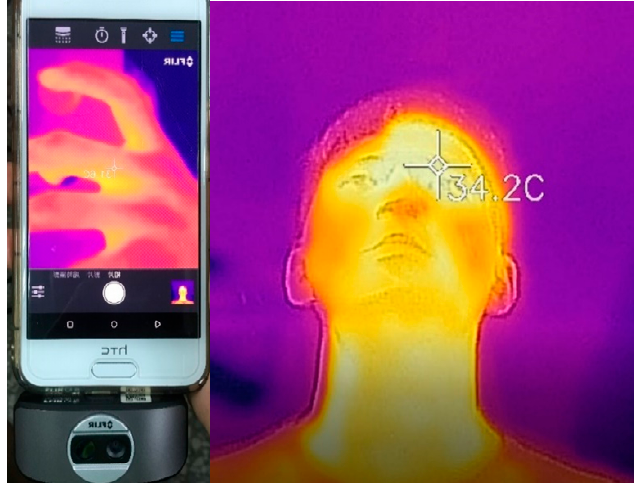
Figure 7. Thermal camera and measured dynamic body temperature map.